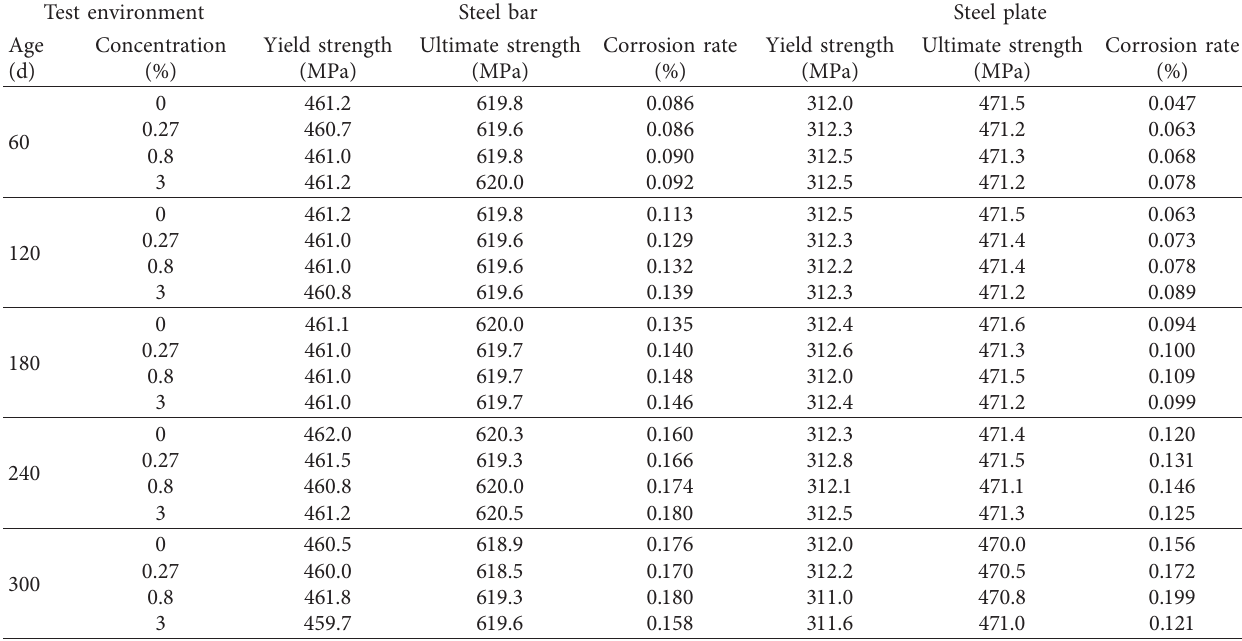
Table 3: Mechanical properties of steel bar and steel plate in an immersion environment.